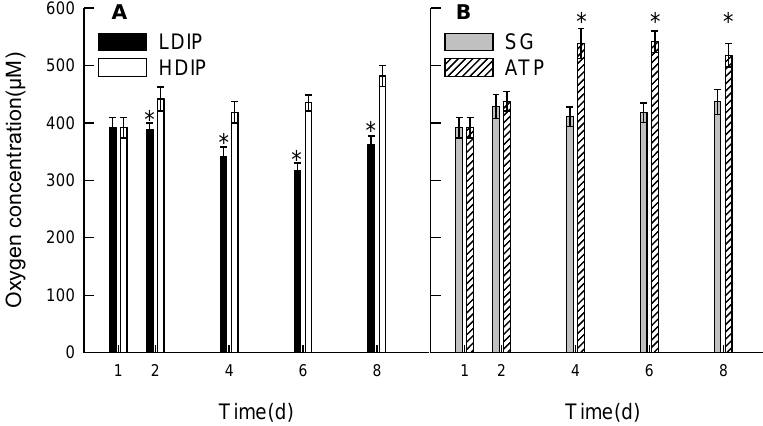
Figure 3. Changes in the oxygen concentration in the C. roscoffensis culture in the groups of inorganic ( A ) and organic ( B ) initial phosphorus resources. (LDIP): low concentration of inorganic phosphorus; (HDIP): high concentration of inorganic phosphorus; (SG): Na 2 -glycerophosphate; (ATP): adenosine triphosphate. * statistical significance, p < 0.05.